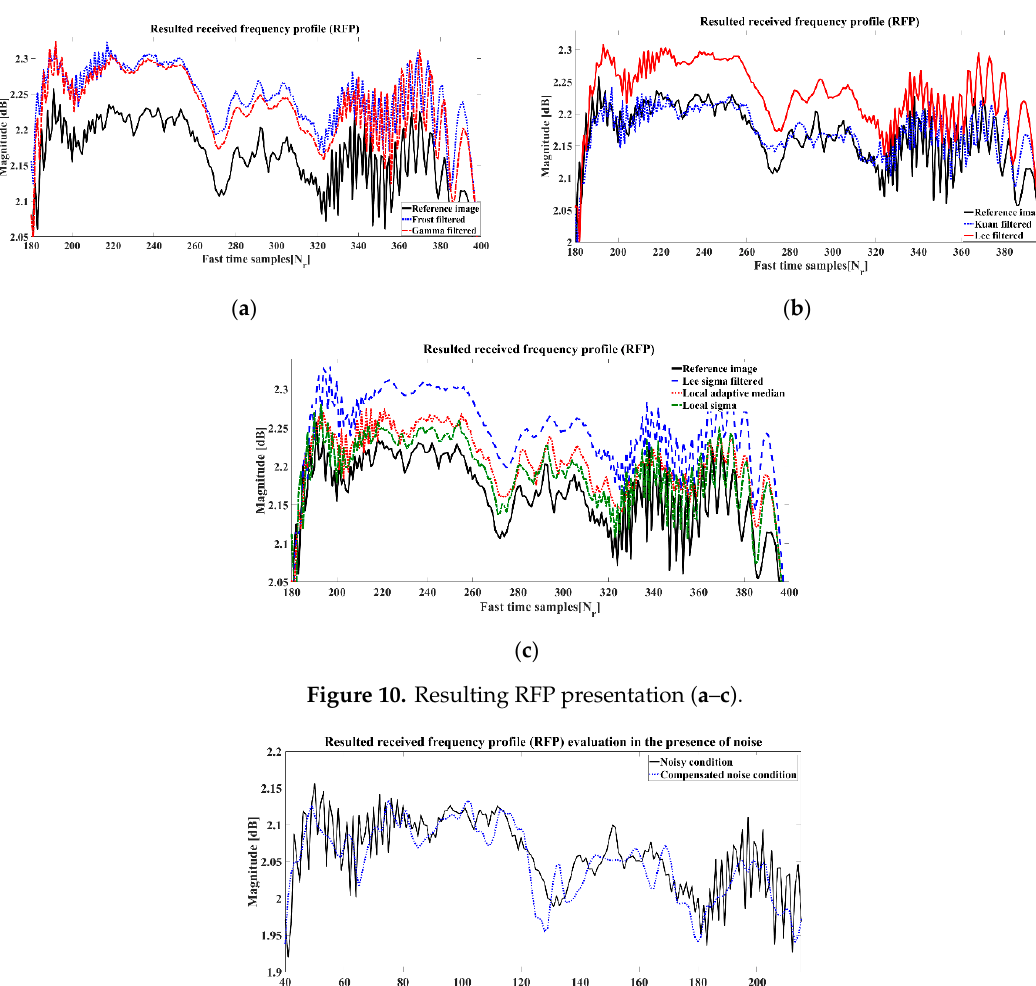
Figure 11. Reference RFP evaluation in the presence of noise and compensated noise conditions.